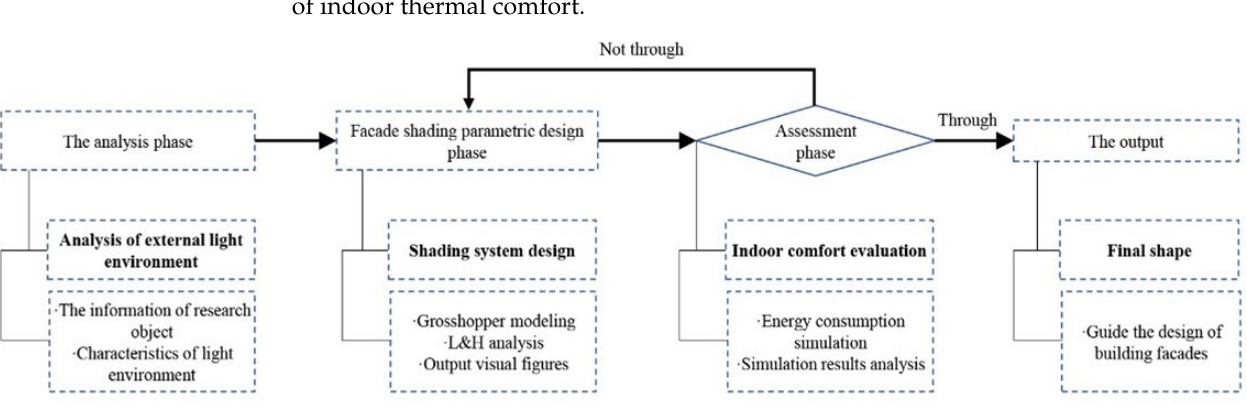
Figure 2. Research flow chart.